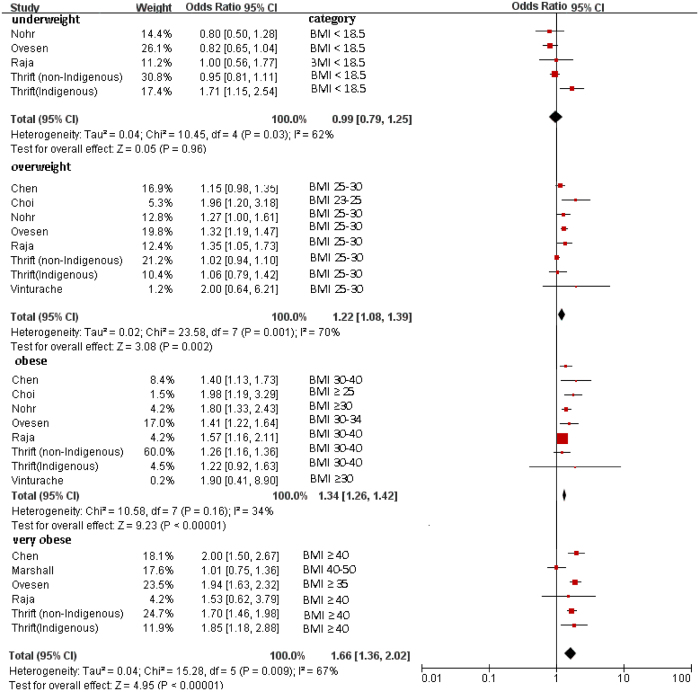
Forest plot of pooled analyses of maternal BMI categories and an Apgar score <7 at 5 minute.Maternal overweight, obesity and very obesity by BMI categories was significantly associated with Apgar score <7. Maternal underweight categories showed nonsignificant trends toward increased an Apgar score <7. Note that reference category was BMI < 25 in Chen et al. study. In other studies, ORs are for each category as compared with the “normal weight” category (BMI 18–25).